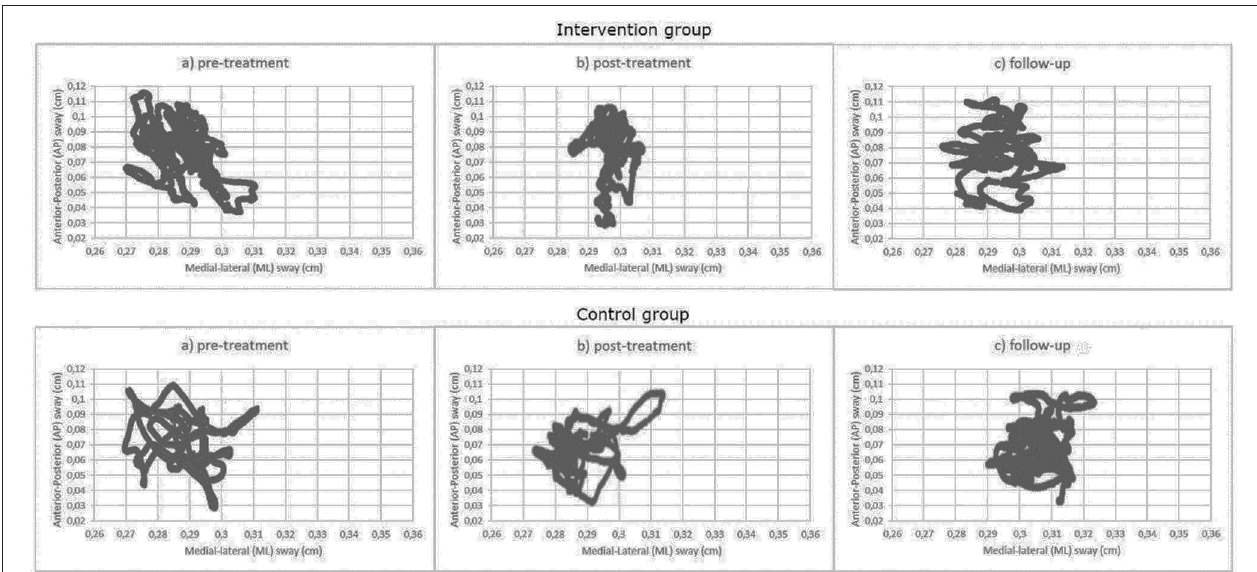
FIGURE 5 | Mean of medial-lateral body sway (axis X) and anteroposterior body sway (axis Y) for the WBV group and the control group at the three assessment times.